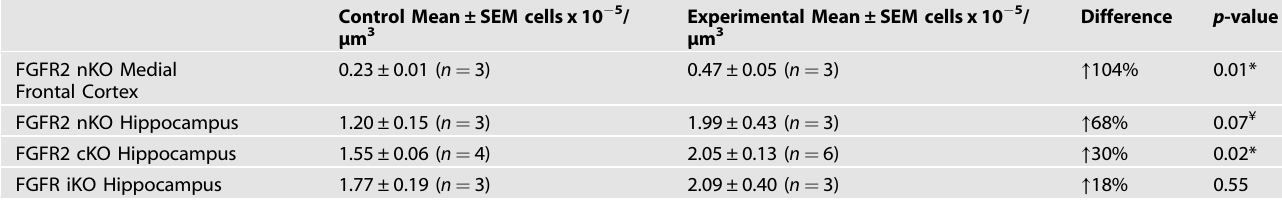
Table 1. Glutamine Synthetase + cell density differences with reduction of FGFR2